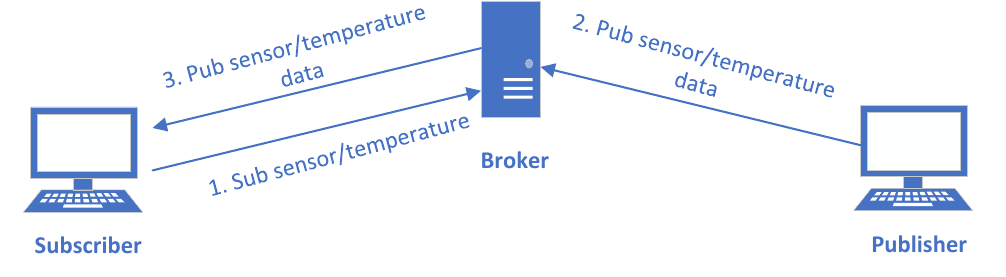
Figure 1. A typical publish/subscribe process of the Message Queue Telemetry Transport (MQTT) protocol (some CONNECT and ACK messages are omitted for simplicity).